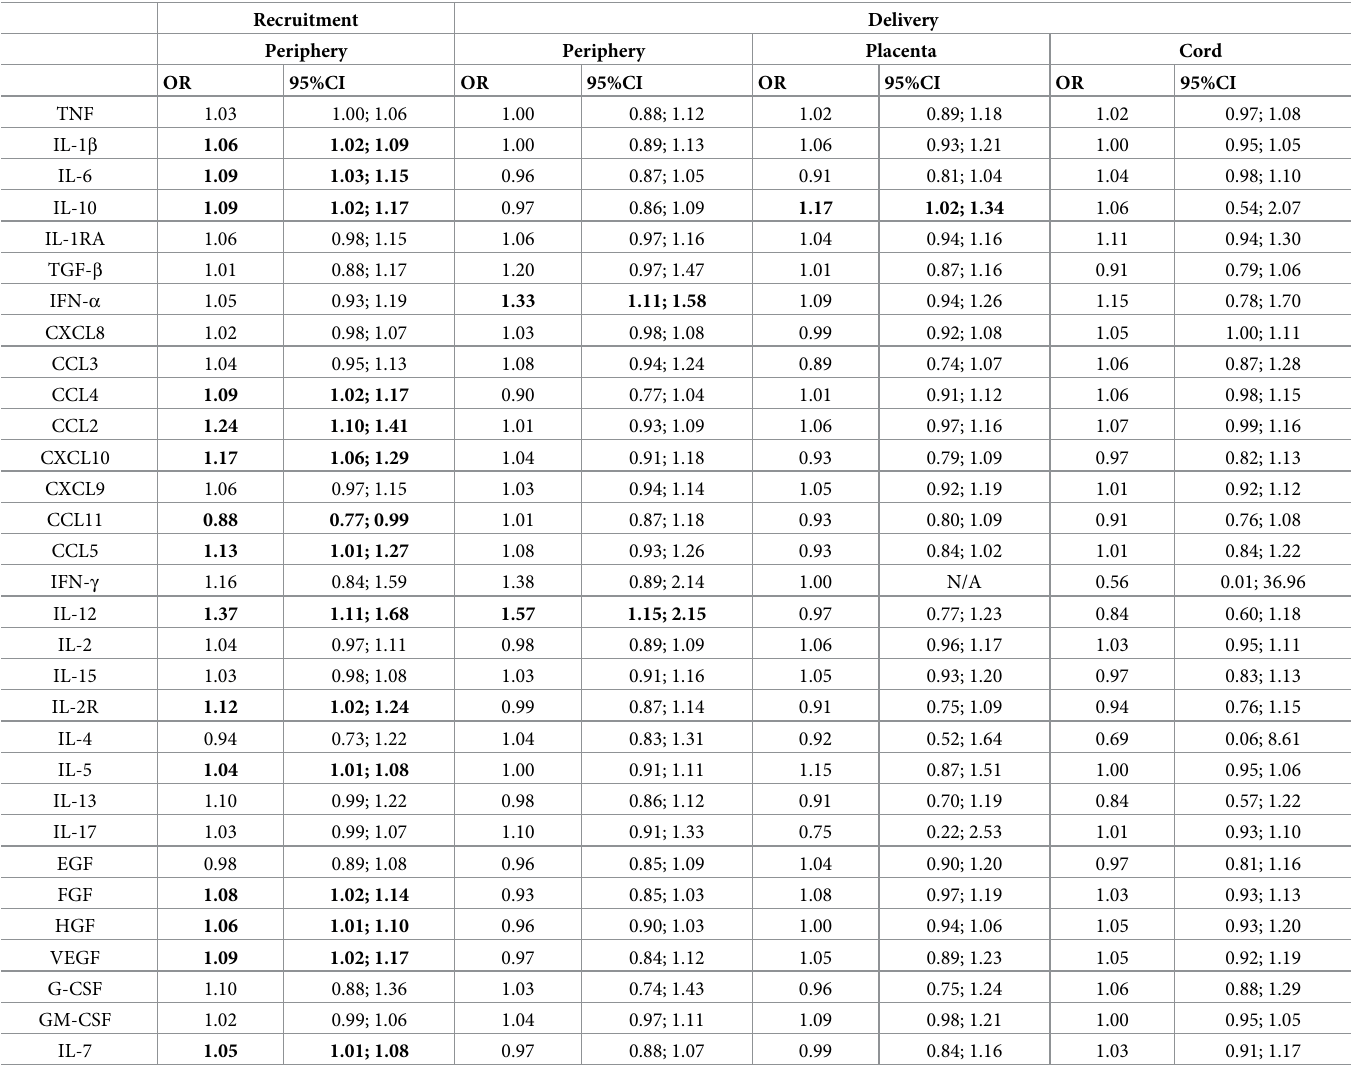
Table 3. Association of plasma biomarker concentration with P . vivax